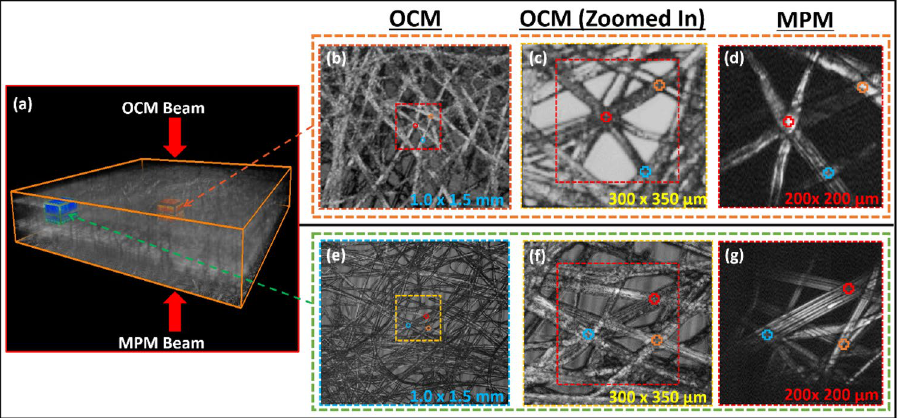
Figure 4. Evaluating the robustness of the PD–PT OCM-guided MPM with complex network phantom sample. ( a ) is the 3D volumetric OCM image of the sample. ( b , c , e , f ) are OCM en face images of the complex network phantom sample. ( c , f ) are the enlarged regions indicated by dashed squares in ( b ) and ( e ), respectively. ( d , g ) are the stacked SHG en face images of the same location scanned in ( c ) and ( f ). Additionally, in ( a ), the rectangular boxes in orange and blue indicate the stacking depth range for SHG images at the initial and moved ROIs at the desired locations,